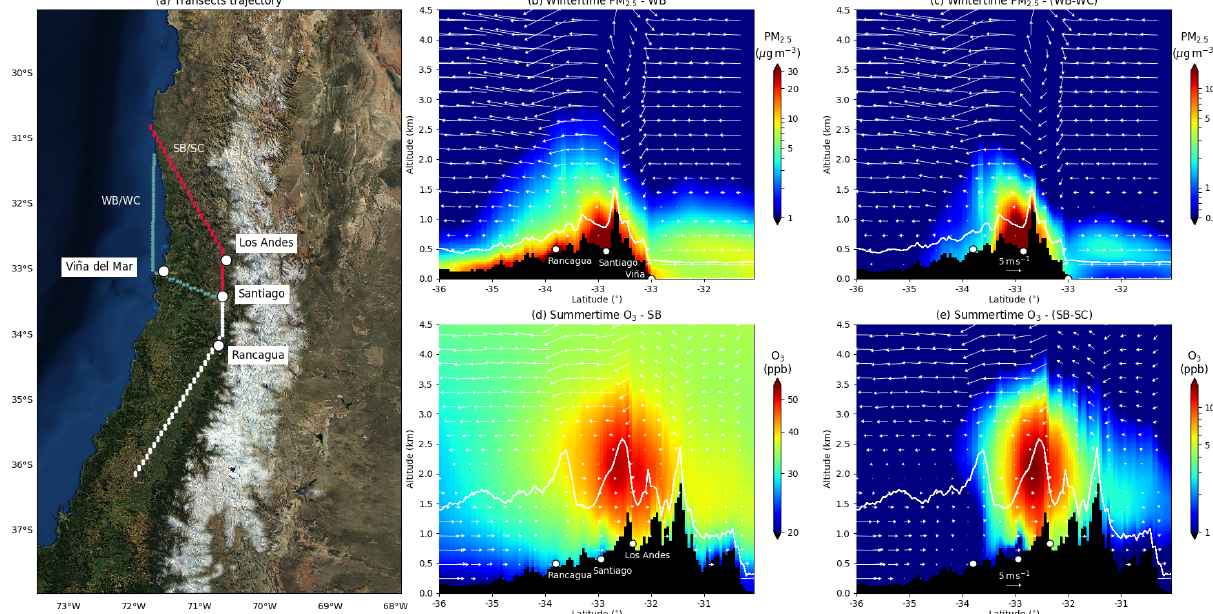
Figure 9. (a) Trajectory of the considered latitude and altitude transects and main locations along the way. The white dotted line up to Santiago is common for both seasons, the blue dotted line is for wintertime, and the red dotted line is for summertime. Values in the transects are not zonally averaged; they correspond to the grid points represented with dots. (b) Simulated PM 2 . 5 concentrations (color map), wind (white arrows), afternoon boundary layer (white solid line), and terrain elevation (black area) along the white and blue transect; average for wintertime 2015 for the WB scenario. Panel (c) is the same as panel (b) for scenarios WB–WC. (d) Simulated O 3 mixing ratios (color map), wind (white arrows), afternoon boundary layer (white solid line), and terrain elevation (black area) are shown along the white and red transect; average for summertime 2015 for the SB scenario. Panel (e) is the same as panel (d) for scenarios SB–SC. Map background layer source: Imagery World 2D, © 2009